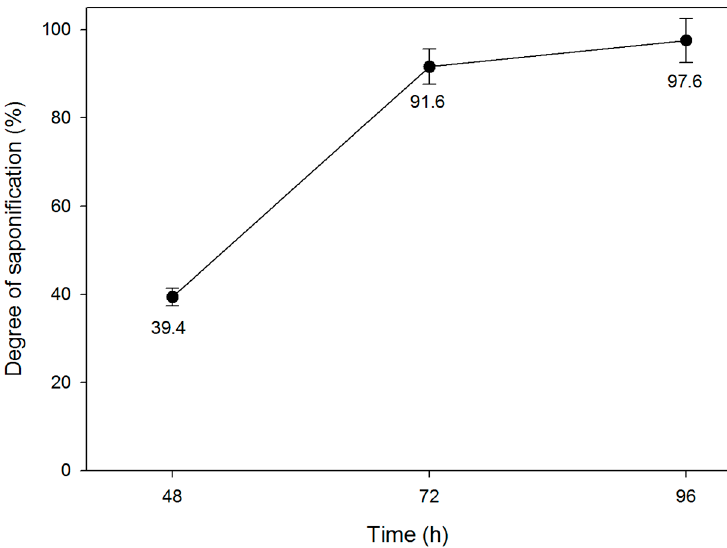
Figure 7. Effect of the saponification time on the DS of the PVAc film. (The saponification conditions were 10 g of NaOH, 10 g of Na 2 SO 4 , 10 g of MeOH, and 100 g of H 2 O at 50 °C).